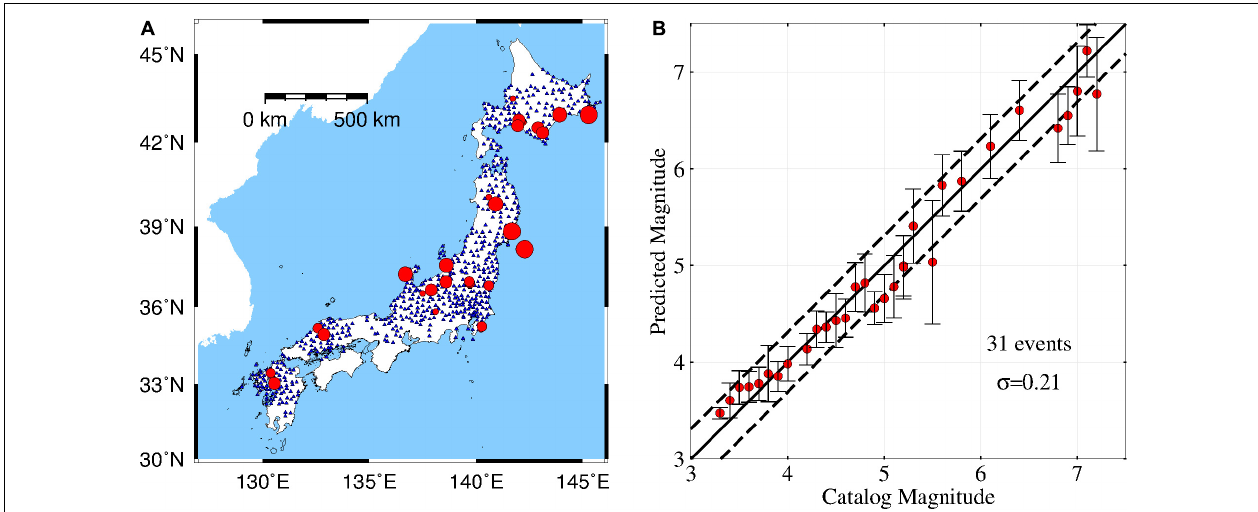
FIGURE 6 | (A) The distribution of the epicenter locations and stations for 31 additional earthquakes. The solid red circles of different sizes represent magnitudes of 3 ≤ M JMA ≤ 7.2. The solid blue triangles represent stations that recorded the 31 events. (B) Magnitudes determined using the DCNN-M model versus the catalog magnitudes for the 31 additional events. On the solid black 45 ◦ line, the predicted magnitude is equal to the catalog magnitude. The two black dashed lines indicate the locations (0.31) of the one standard deviation of errors for the DCNN-M model. The solid red circles show the mean of the estimated magnitudes of the DCNN-M model for the earthquake events. The length of the black bar shows the standard deviation of the magnitude estimation errors for each event.